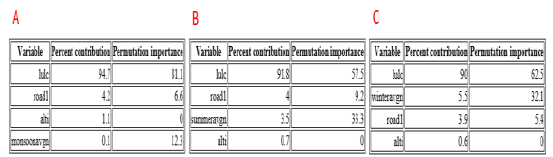
Figure 6 – Road network (black) in the study area and a 1 km buffer around the roads (blue). B A Figure 9 – Maxent output – A- Monsoon 2016, B- Summer 2016, and C- Winter 2016. Dark blue colour represents 0 i.e. least suitability while red colour represents 1 i.e. high suitability.